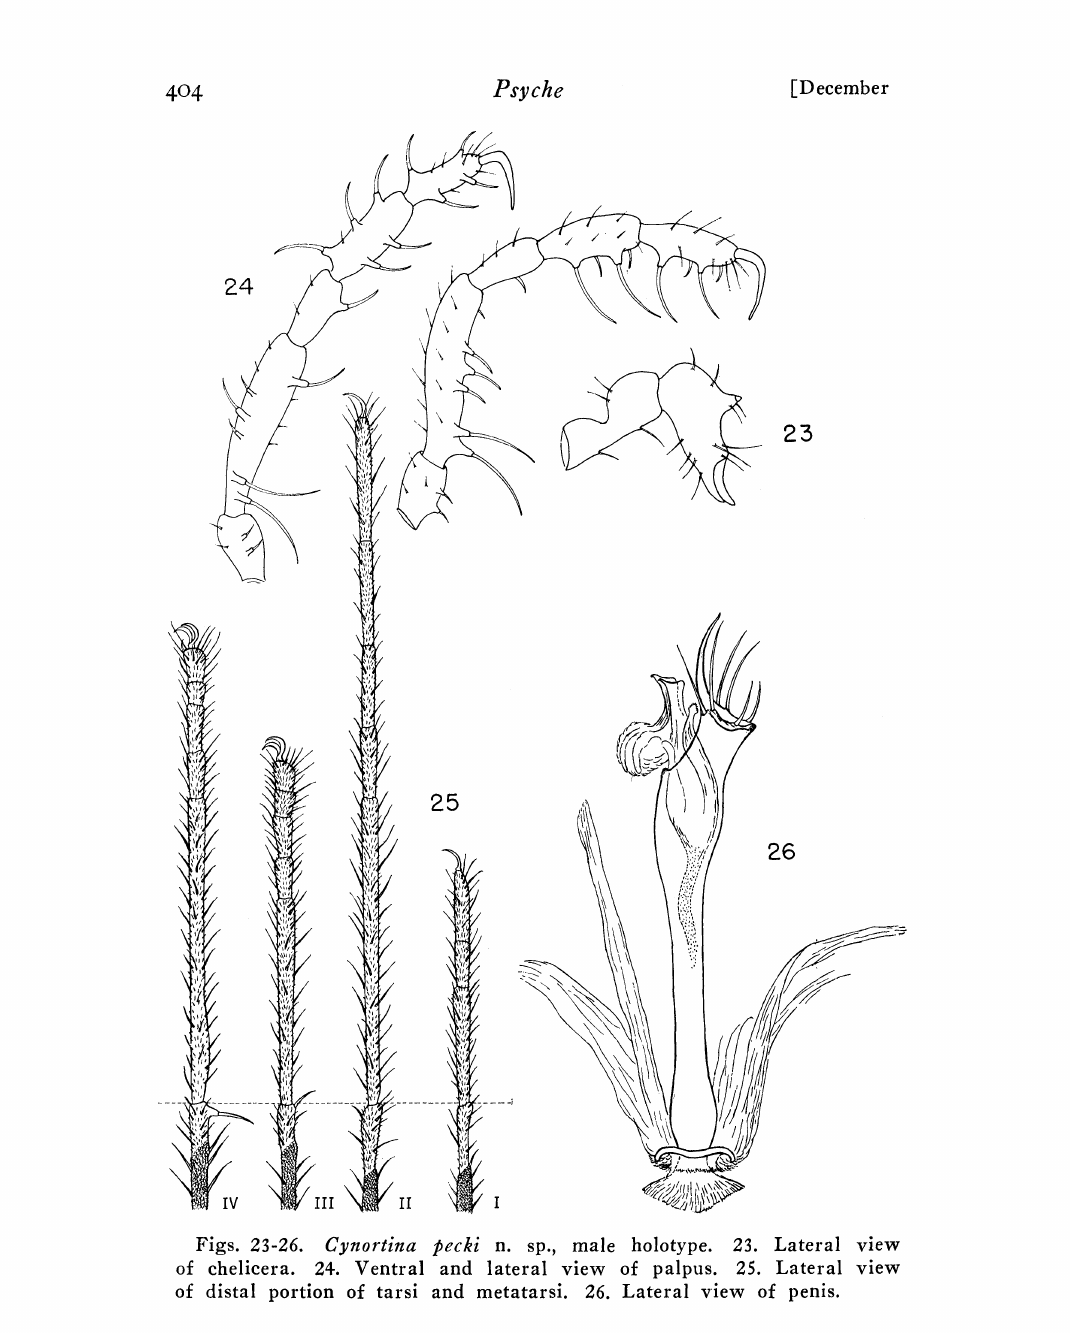
Figs. 23-26. Cynortina pecki n. sp., male holotype. 23. Lateral view of ehelieera. 24. Ventral and lateral view of palpus. 25. Lateral view of distal portion of tarsi and metatarsi. 26. Lateral view of